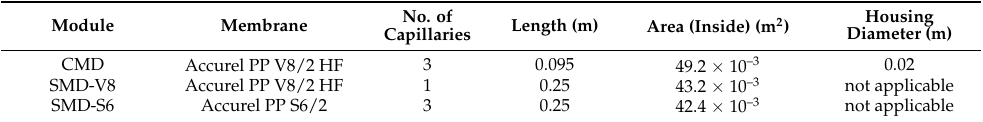
Table 1. Characteristics of the capillary MD modules.